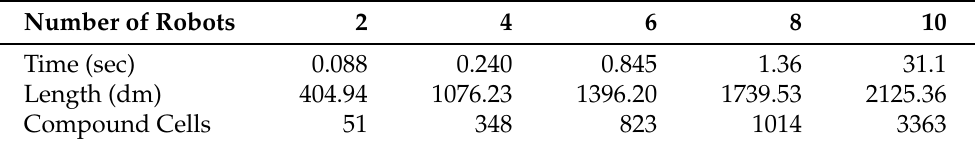
Table 1. Execution time, total length of the robots’ paths and number of generated compound cells required by the high-level planner for solving each